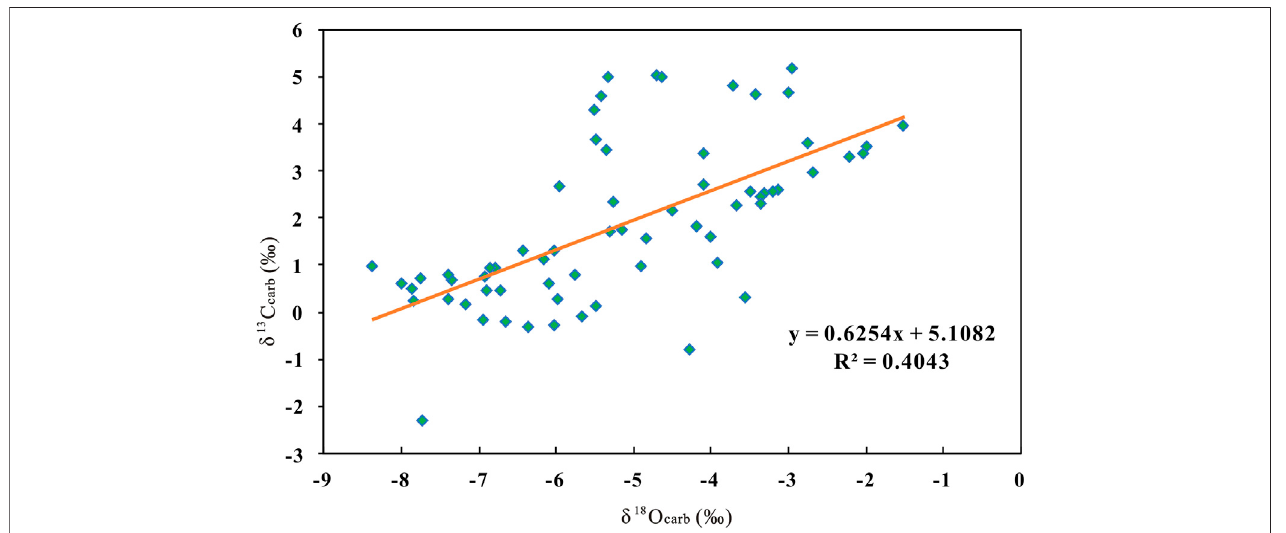
FIGURE 4 | Correlation between δ 18 O carb and δ 13 C carb in the HL18-3 core.